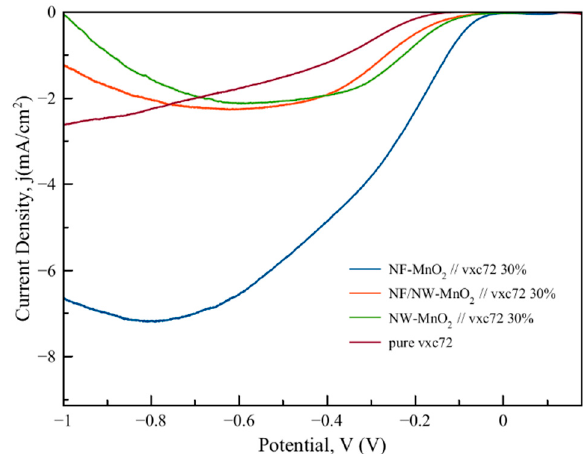
Figure 4. Linear sweep voltammetry curves of all prepared MnO 2 catalysts.